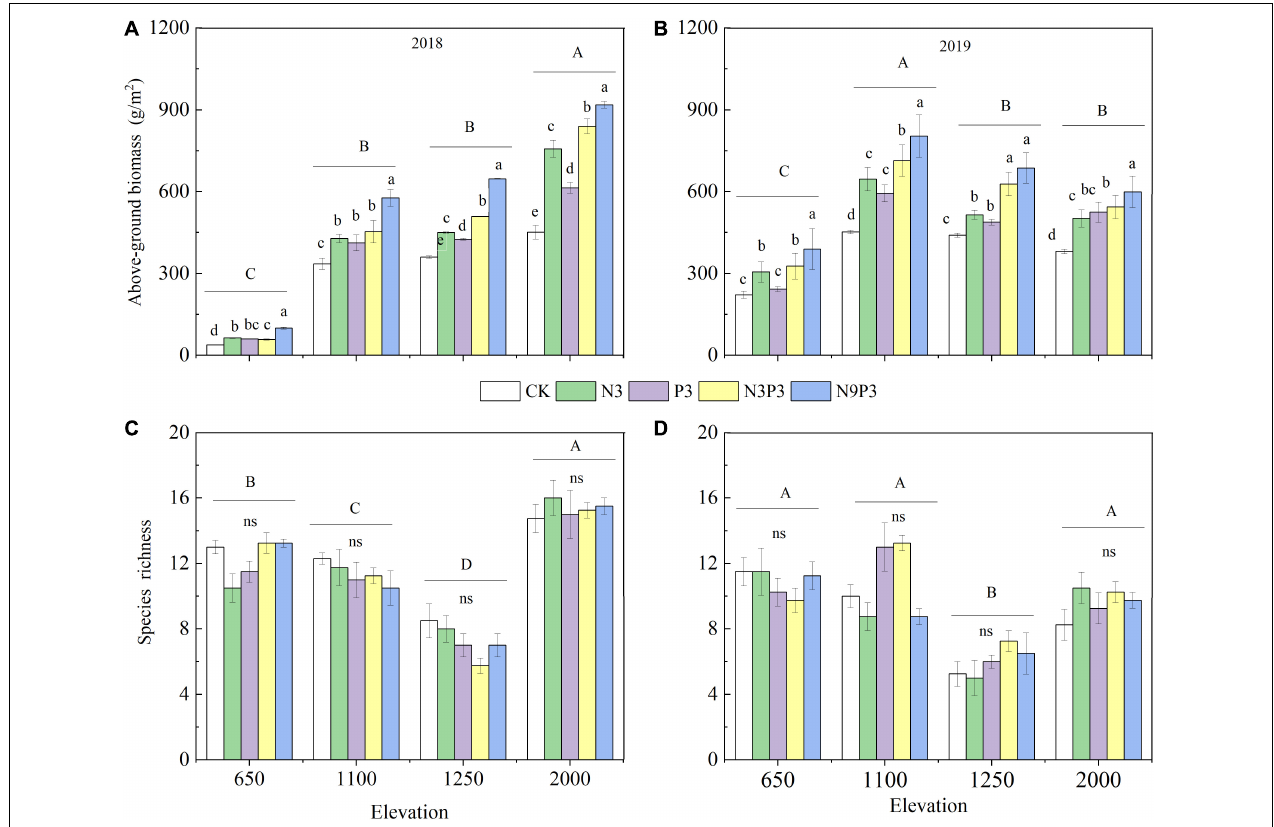
FIGURE 3 | Changes in the above-ground biomass (A,B) and species richness (C,D) changing under different nutrient treatments at different elevations in 2018 (left) and 2019 (right). Within each panel, groups with the same capital letters above them are not significantly different at p < 0.05 (Duncan’s test). Within each group of five bars, bars sharing the different letters are significantly different from each other at p < 0.05. Letters are not presented when none of the five bars differs significantly from any of the others (Duncan’s test), ns means that differences are not significant. The data were showed as mean ± SE.